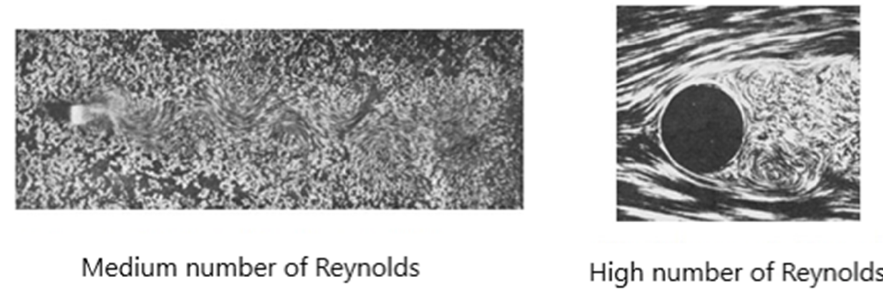
Figure 16. Medium and High performance of Reynolds source: [38]. The results of the fluid analysis on the blade structure indicate that the blades suffer resistance forces that range from a minimum of 20,794.68 Pa to a maximum of 187,251.09 Pa, as can be seen in Figures 17 and 18. The software used for this study is SolidWorks Flow Simulation